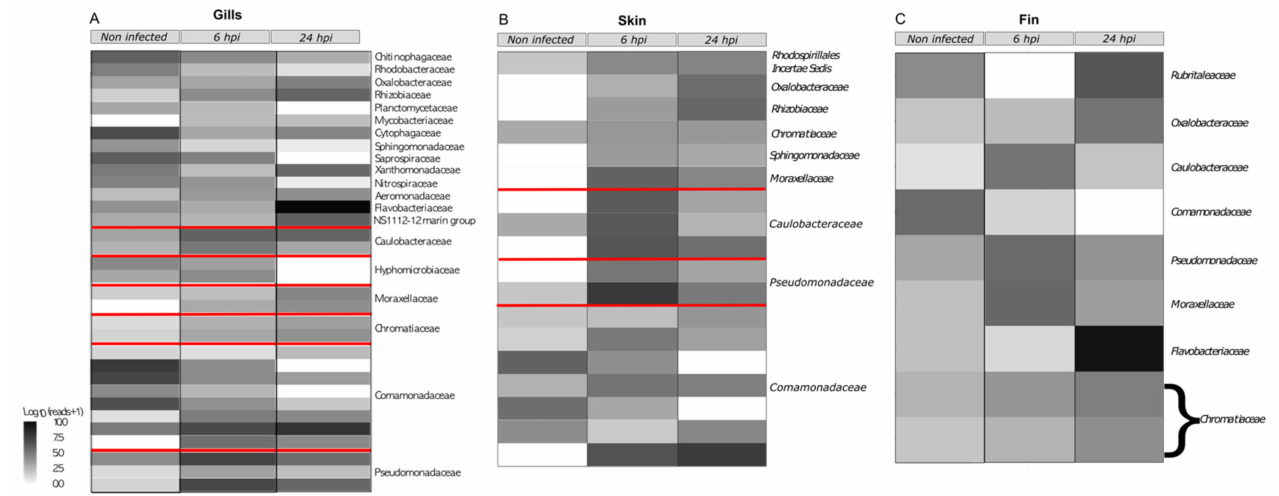
Figure 3. Heatmaps representing gills ( A ), skin ( B ), and fin ( C ) negative binomial GLM associated correlated network (Supplementary Materials S5, S6, S7). Red lines delimitate OTUs representing the same bacterial